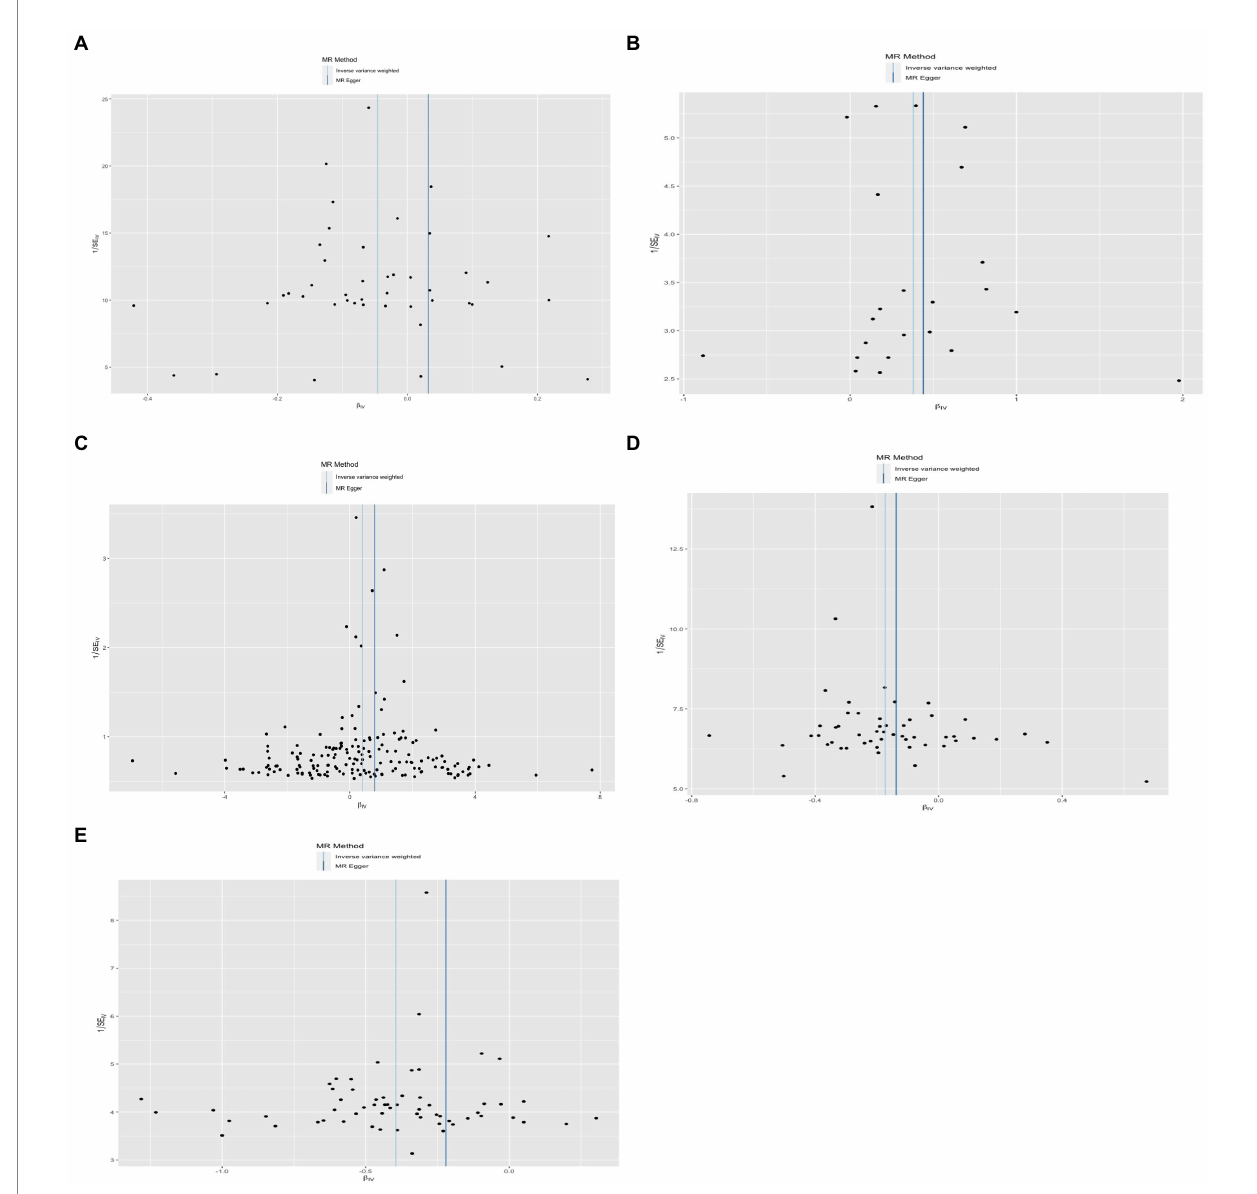
FIGURE 4 Results of the funnel plot. (A) Lower birth weight (BW)-Alzheimer’s disease (AD); (B) childhood body mass index (BMI)-attention-deficit hyperactivity disorder (ADHD); (C) early life body size-ADHD; (D) age at first birth (AFB)-major depressive disorder (MDD); (E) AFB-ADHD; the solid dot means the causal effects of exposure on outcomes with four methods [MR-Egger (MRE); weighted median (WM); weighted mode (Wm); inverse-variance weighting (IVW); MR-Egger and Mendelian Randomization Pleiotropy RESidual Sum and Outlier (MR-PRESSO)]. The results of the binary outcomes are shown by OR [95%CI]. Numbers in bold mean P- values <5.00E-02, and italic and bold font means P- values